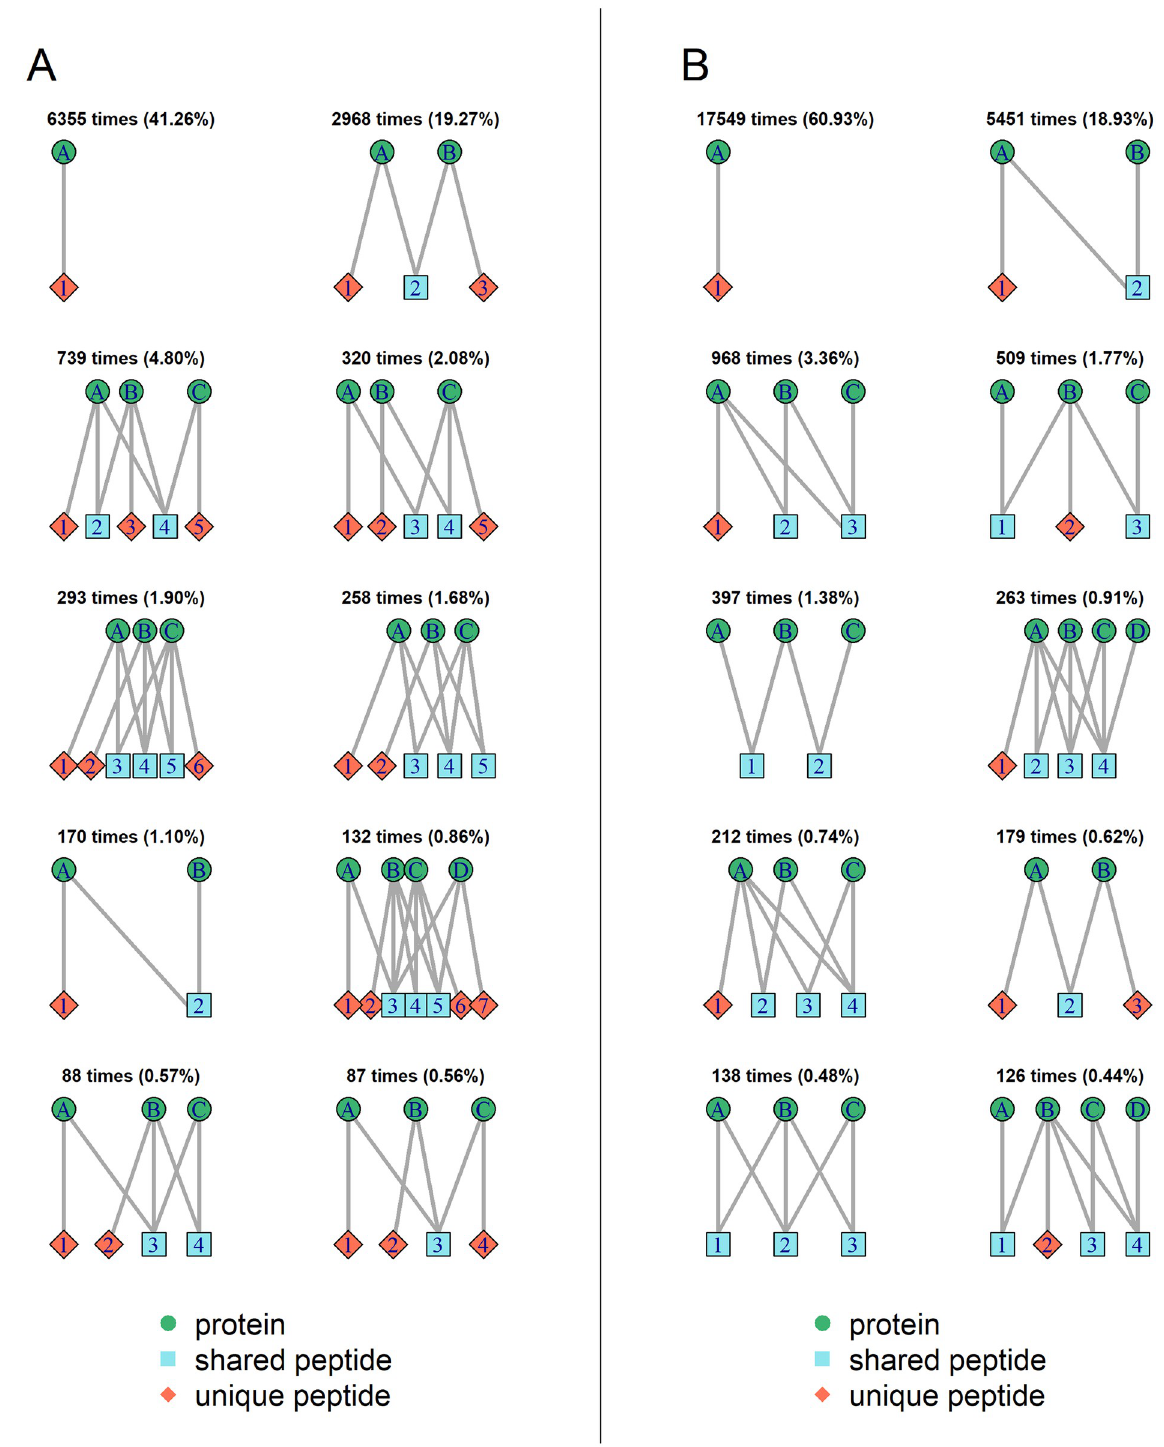
Fig 2. Representative bipartite graphs for the ten largest isomorphism classes found in data set D1. A) D1_fasta, B) D1_quant, with number of occurrences and percentage of all graphs.